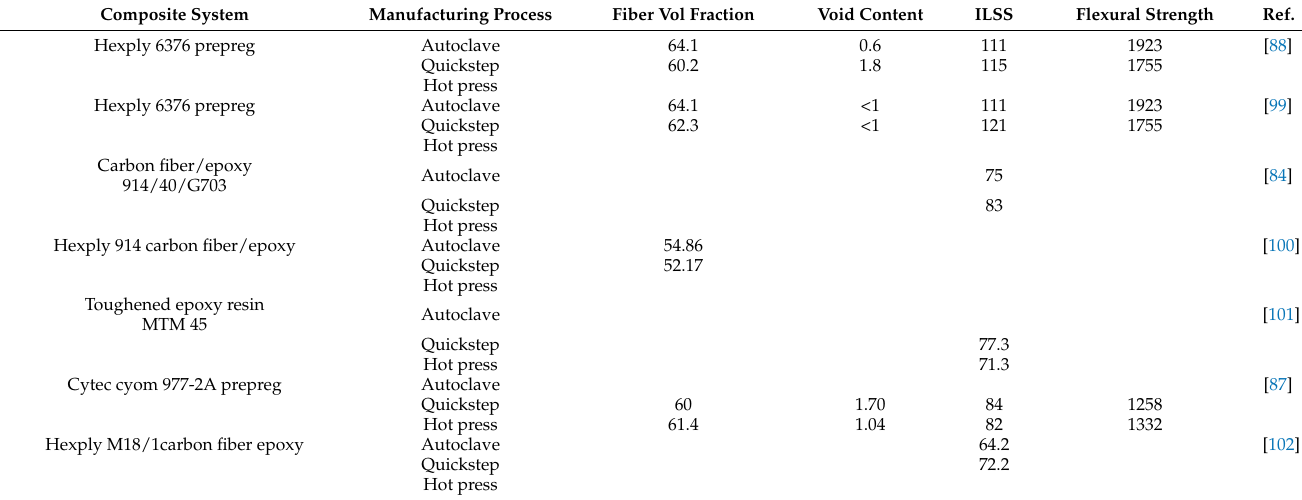
Table 5. Mechanical Properties of Composites Manufactured Using Different